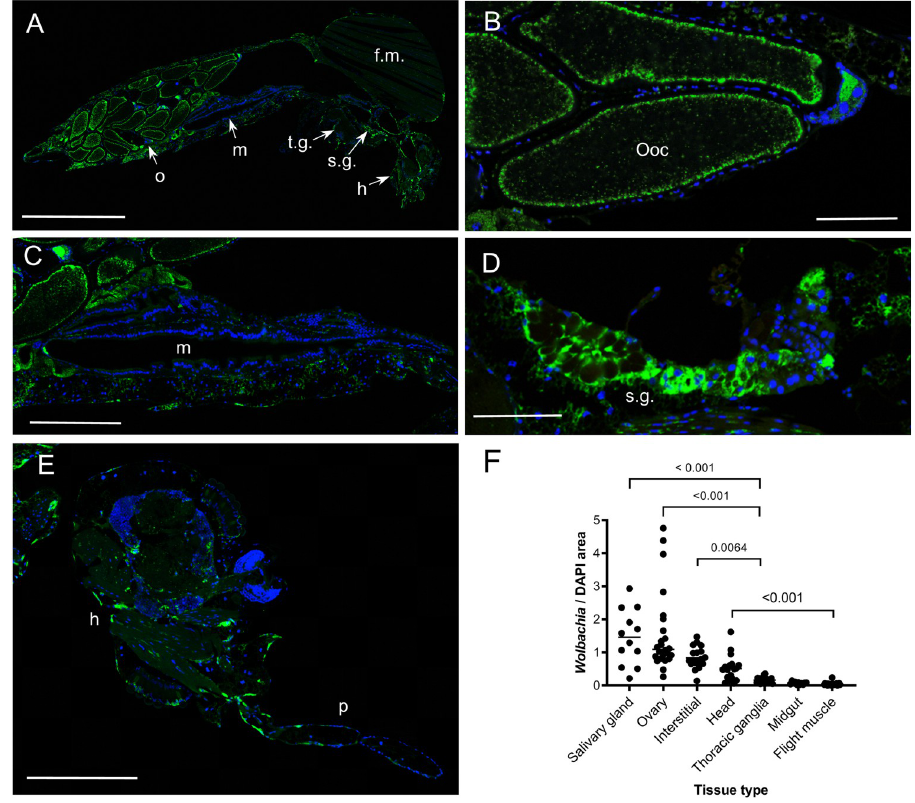
Fig 1. Histology of Wolbachia infection in the Aedes aegypti w AlbB2-F4 strain. Wolbachia infection was observed across mosquito organs/tissue types by immunofluorescence analysis (IFA) using a rabbit polyclonal antibody against the Wolbachia surface protein (WSP) as the primary antibody and Alexa Fluor 488-conjugated donkey anti-rabbit antibody as the secondary antibody. DNA was stained using DAPI. (A) Example of whole body section showing IFA staining. (B-E) High resolution images of Wolbachia staining in oocytes, midgut, salivary gland and heads, respectively. (F) Quantification of Wolbachia staining density. Staining areas were quantified by image analysis and expressed as a ratio of Wolbachia staining over DAPI staining for each organ/tissue. The median staining densities differed significantly between groups (Kruskal-Wallis statistic = 95.37, N = 124). P values are reported for comparisons where medians differed significantly by Dunn’s multiple comparison test ( α = 0.05, 21 comparisons).